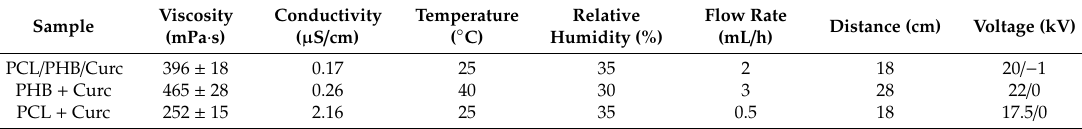
Table 1. Properties and processing parameters of fibrous membranes fabricated by